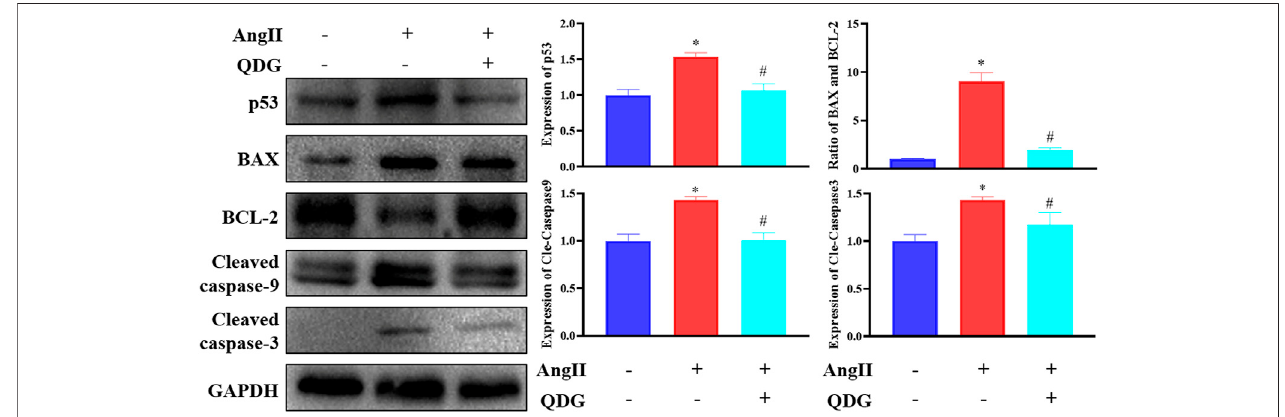
FIGURE 6 | QDG inhibits activation of p53 signaling pathways induced by angiotensin (Ang II). Western blot analysis was performed to determine the protein expression of p53, BAX, BCL2, and cle-caspase-9/caspase-3. GAPDH was used as the internal control. Data were presented as mean ± SD; * p < 0.05 vs. the Control group, # p < 0.05 vs. the Ang II